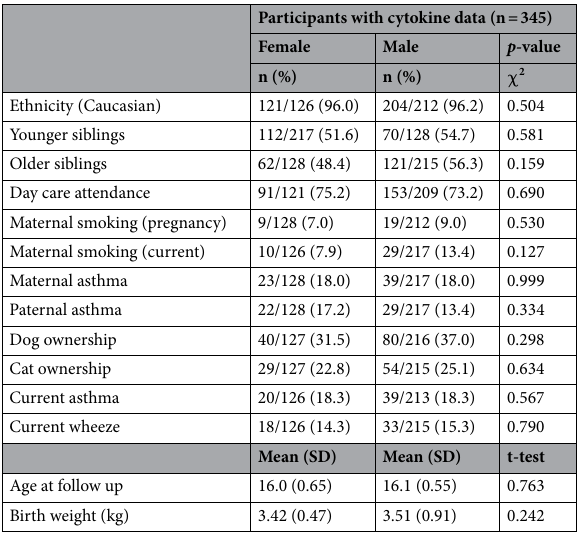
Table 2. Demographic and clinical characteristics of the participants included in the study of innate anti- viral immune responses. Some data was lost due to individuals not attending a follow up visit or skipping the